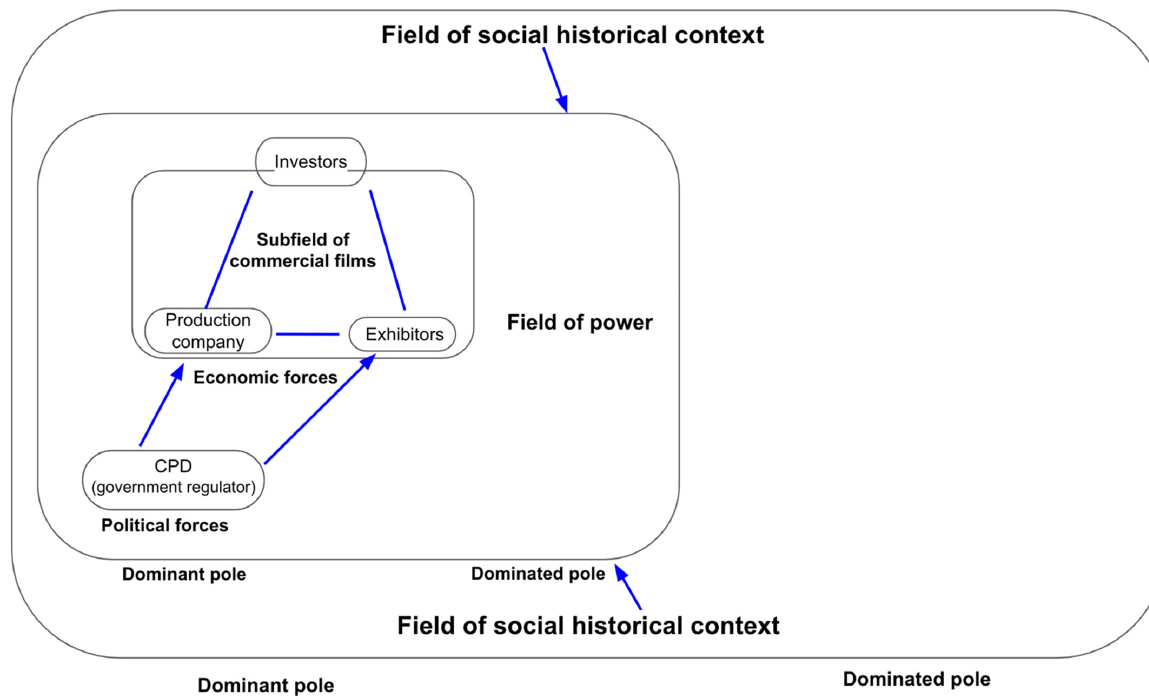
Figure 2. Interrelations among the fields as shown in the case of